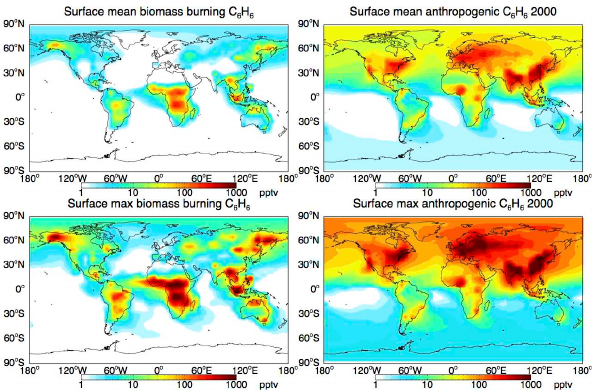
Fig. 4. Top row: model estimate of the annual surface mean mixing ratio of benzene resulting from biomass burning emissions (left) and from anthropogenic emissions (right) using the standard RETRO 2000 scenario. Second row of plots shows the monthly maximum surface mixing ratio from these two sources.